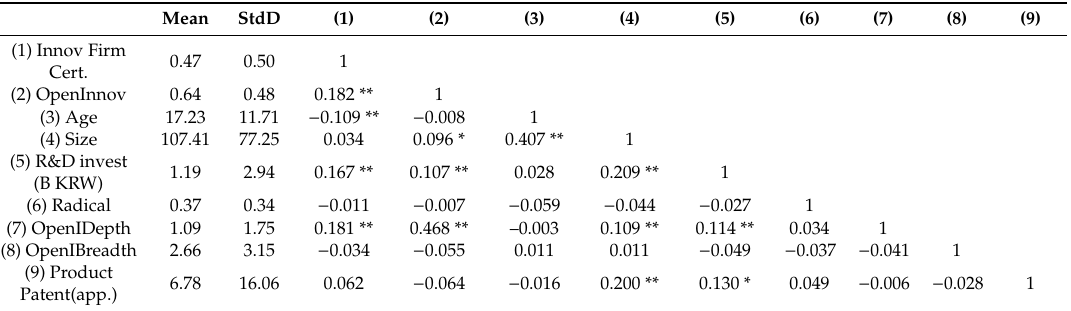
Table 1. Basic statistics of variables.